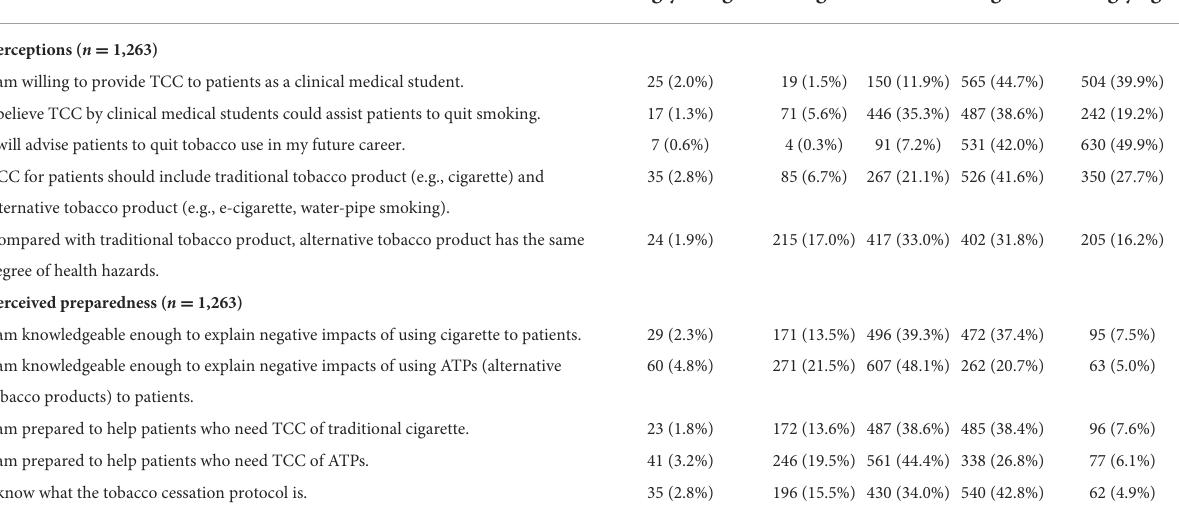
TABLE 2 Clinical medical students’ perceptions and perceived preparedness toward providing tobacco cessation